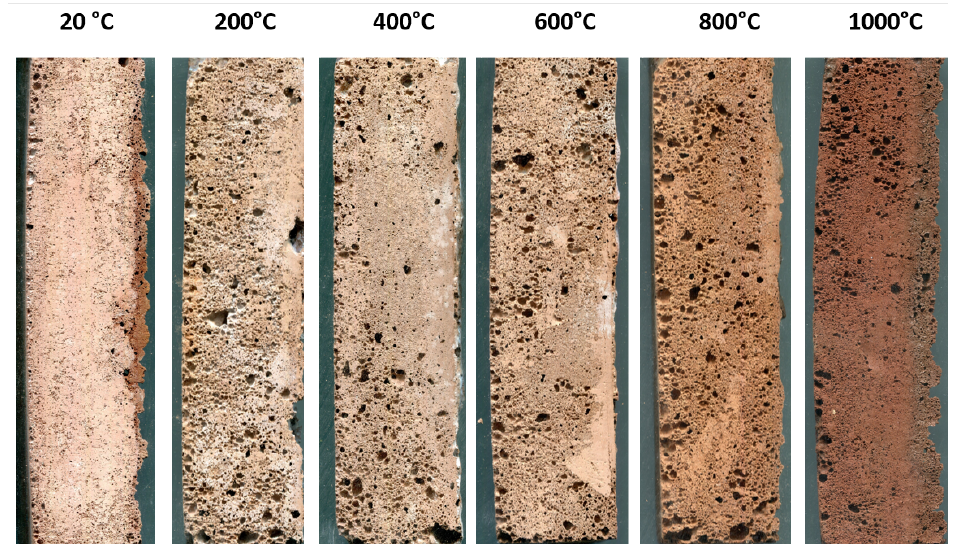
Figure 4. Visual aspect and colour change in heated geopolymer foam Al-2.